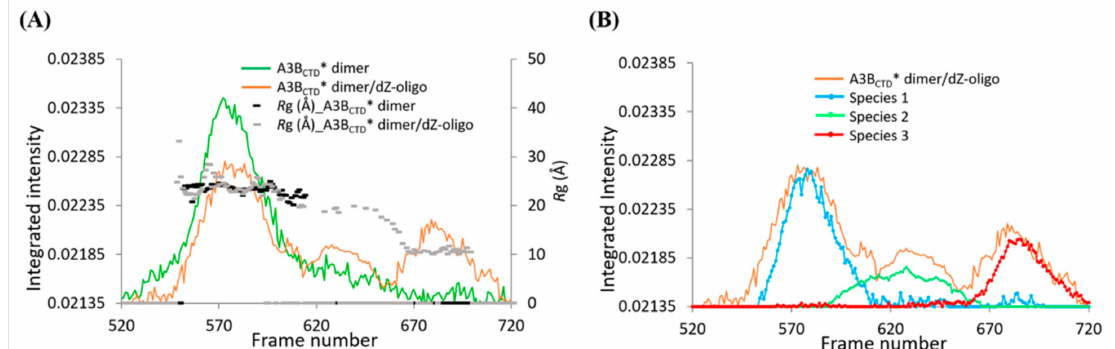
Figure 12. Deconvolution of SAXS data of the A3B CTD * dimer/dZ-oligo. ( A ) Comparison of the SAXS profiles of the A3B CTD * dimer (green) and A3B CTD * dimer with dZ-oligo at a 1 to 10 ratio (orange) overlaid with R g trace values. ( B ) Evolving factor analysis (EFA) analysis using BioXTAS RAW indicating the distinct scattering species